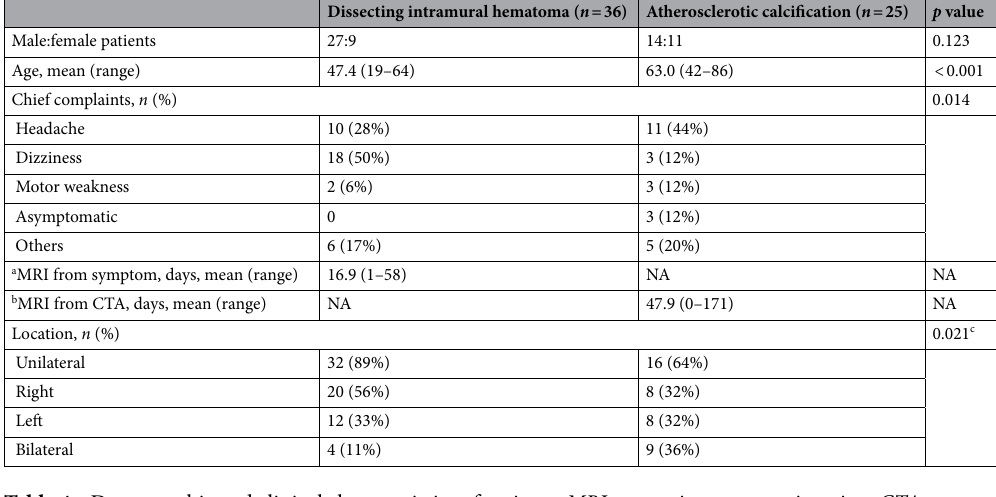
Table 4. Demographic and clinical characteristics of patients. MRI magnetic resonance imaging, CTA computed tomography angiography, NA not available. a MRI from symptom means time intervals of quantitative susceptibility mapping (QSM) MRI from symptom onset. b MRI from CTA means time intervals between QSM MRI and CTA. c Comparison between unilateral vs. bilateral